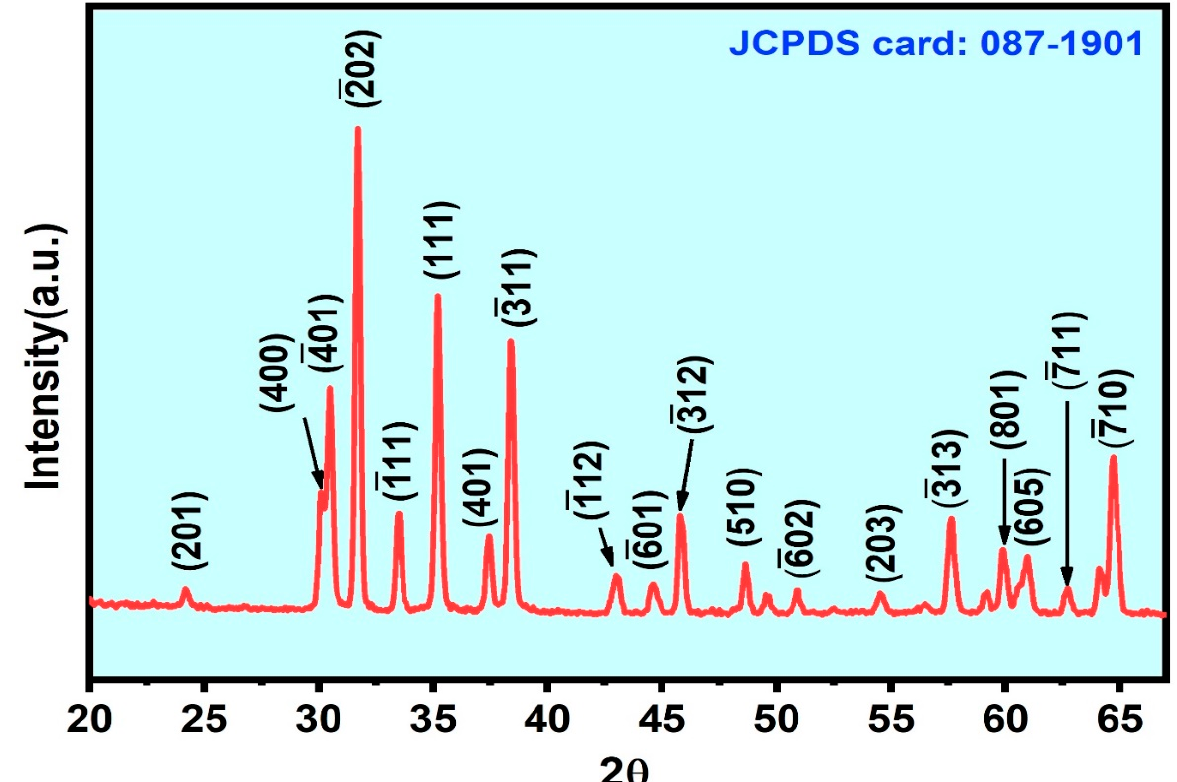
Figure 2. GI-XRD result of as-grown β -Ga 2 O 3 nanowires on Si substrate. FE-SEM (Zeiss Ultra Plus, Oxford Instruments) was employed to investigate the morphology. After the annealing treatment at 900 ◦ C, it was observed that the gold droplets formed uniformly throughout the substrate with an average diameter of 77.74 ± 1.95 nm and, thus, acted as a catalyst. As mentioned in the experimental section, the sample kept ~2 cm away from the source compound resulted in the formation of a spindle wires (1D)-like structure. The FE-SEM image of 1D nanowires is shown in Figure 3a. Meanwhile, it was found that all the nanowires were uniform across the substrate. The average diameter of the nanowires was found by using Gaussian fitting of the calculated diameter of nanowires, which was equal to 144.96 ± 6.36